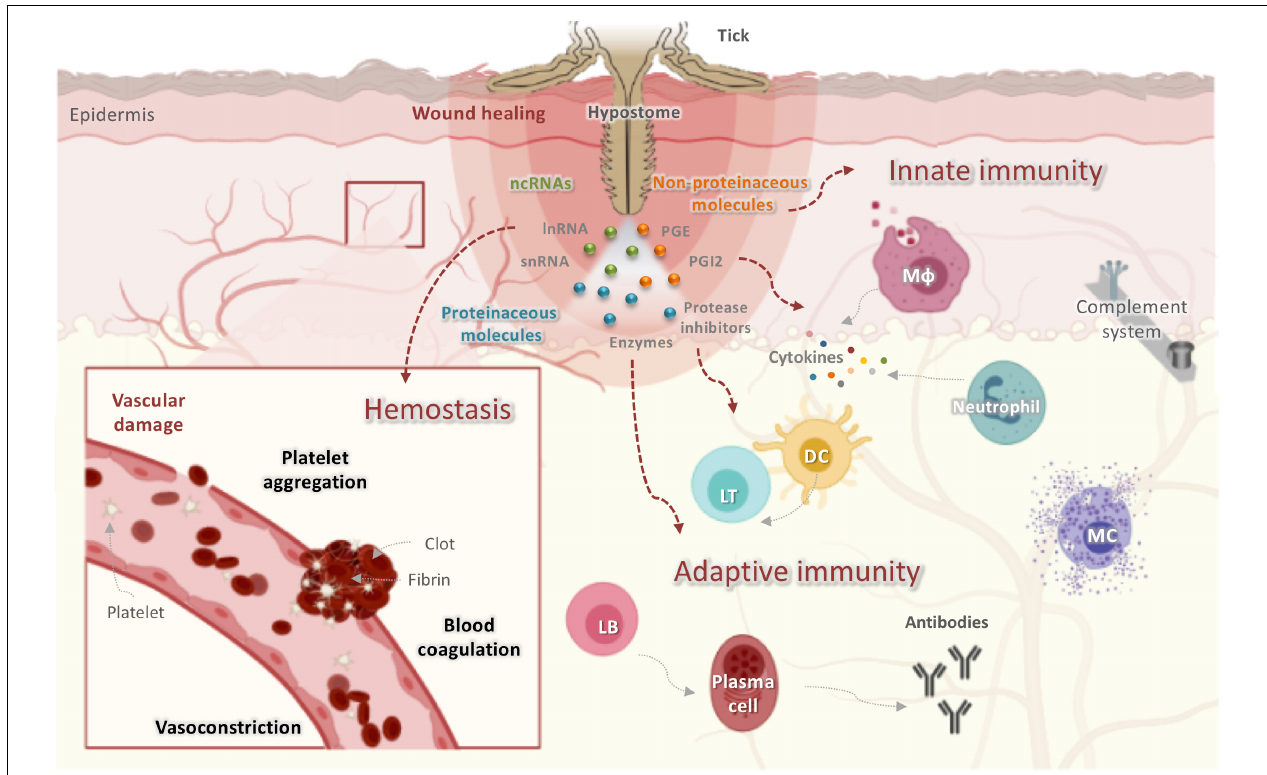
FIGURE 1 | Obstacles faced by ticks at the host-tick interface when taking a blood meal. Ticks initiate feeding by inserting their hypostomes into host skin, resulting in tissue and vascular damage. The host has developed several mechanisms to prevent blood loss including activating hemostasis, innate and adaptive immunity, the complement pathway, and inflammatory responses leading to wound healing and tissue remodeling, all of which disrupt tick feeding. Ticks, in turn, secrete saliva at the bite site that contains proteinaceous molecules (enzymes, lipocalins, protease inhibitors, etc.), non-proteinaceous molecules (prostaglandins, prostacyclins), and ncRNAs (miRNAs and lncRNAs). These molecules display anticoagulatory, antiplatelet, vasodilatory, anti-inflammatory, and immunomodulatory activities to counter host reactions and to guarantee a successful blood meal. DC, dendritic cells; LT, lymphocyte T; LB, lymphocyte T; M ϕ ,